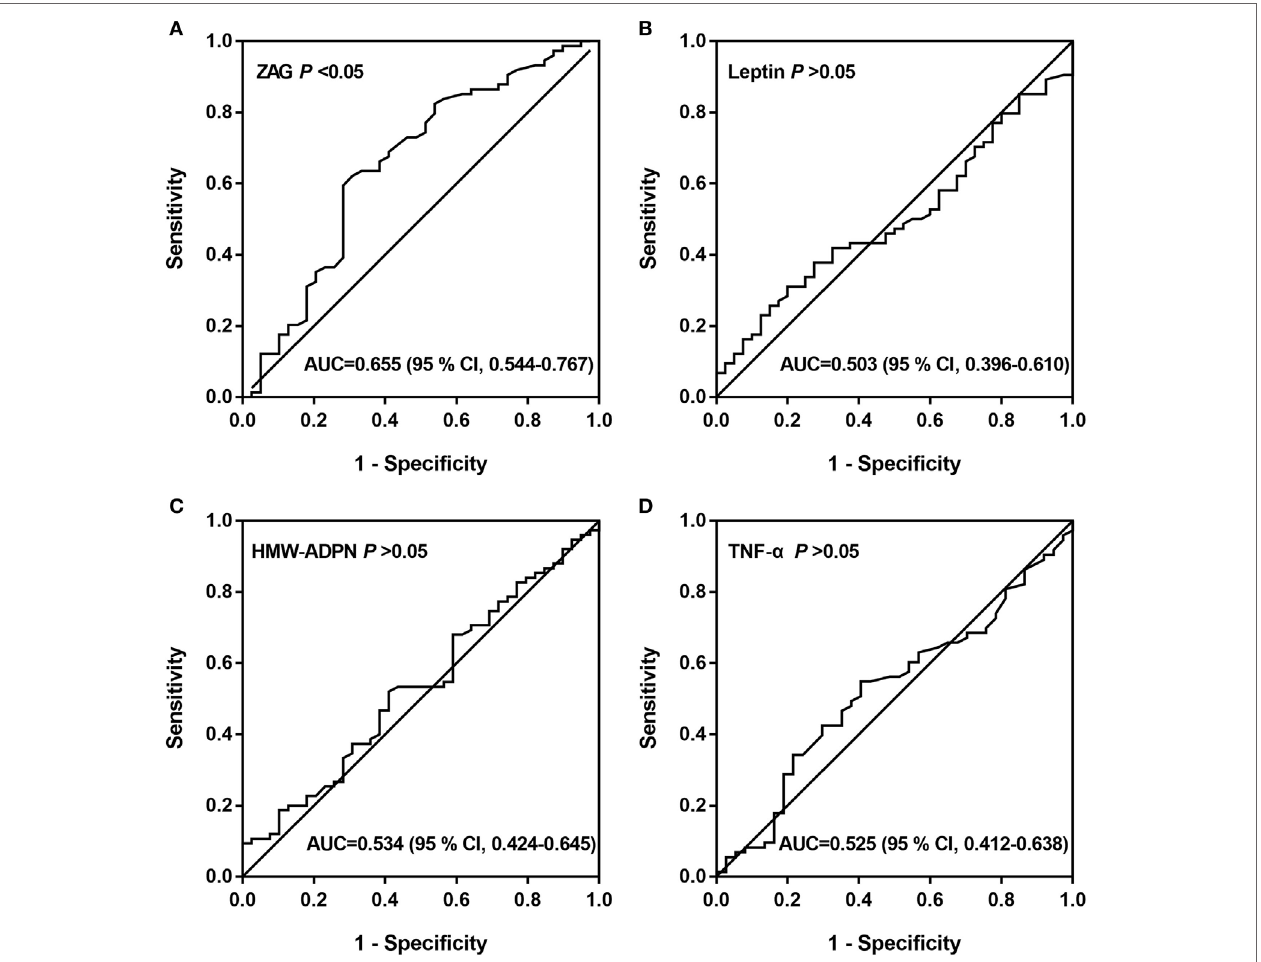
FigUre 3 | ROC curves of serum ZAG (a) , leptin (B) , HMW-ADPN (c) , and TNF- α (D) . ROC curves were derived by plotting the relationship between the specificity and the sensitivity at various cutoff levels. Abbreviations: ZAG, zinc- α 2-glycoprotein; HMW-ADPN, high-molecular-weight-adiponectin; TNF- α , tumor necrosis factor-alpha; ROC, receiver operating characteristic; AUC, area under the